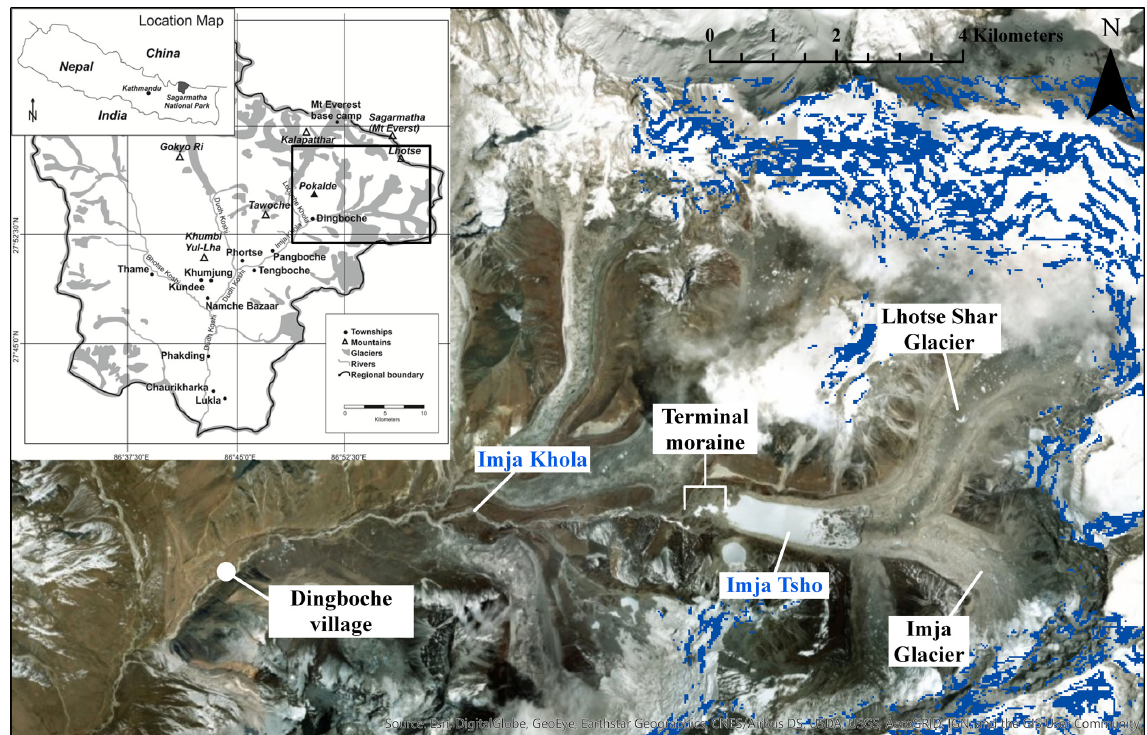
Figure 1. Overview of the study area showing the Mount Everest region (inset; Nicholson et al., 2016), Imja Tsho, primary glaciers, avalanche-prone hanging ice (dark blue; Rounce et al., 2016), and the Imja Khola channel down to Dingboche village. Source: Digital- Globe, Inc. (imagery); inset reprinted from Nicholson et al. (2016) under Creative Commons Attribution International